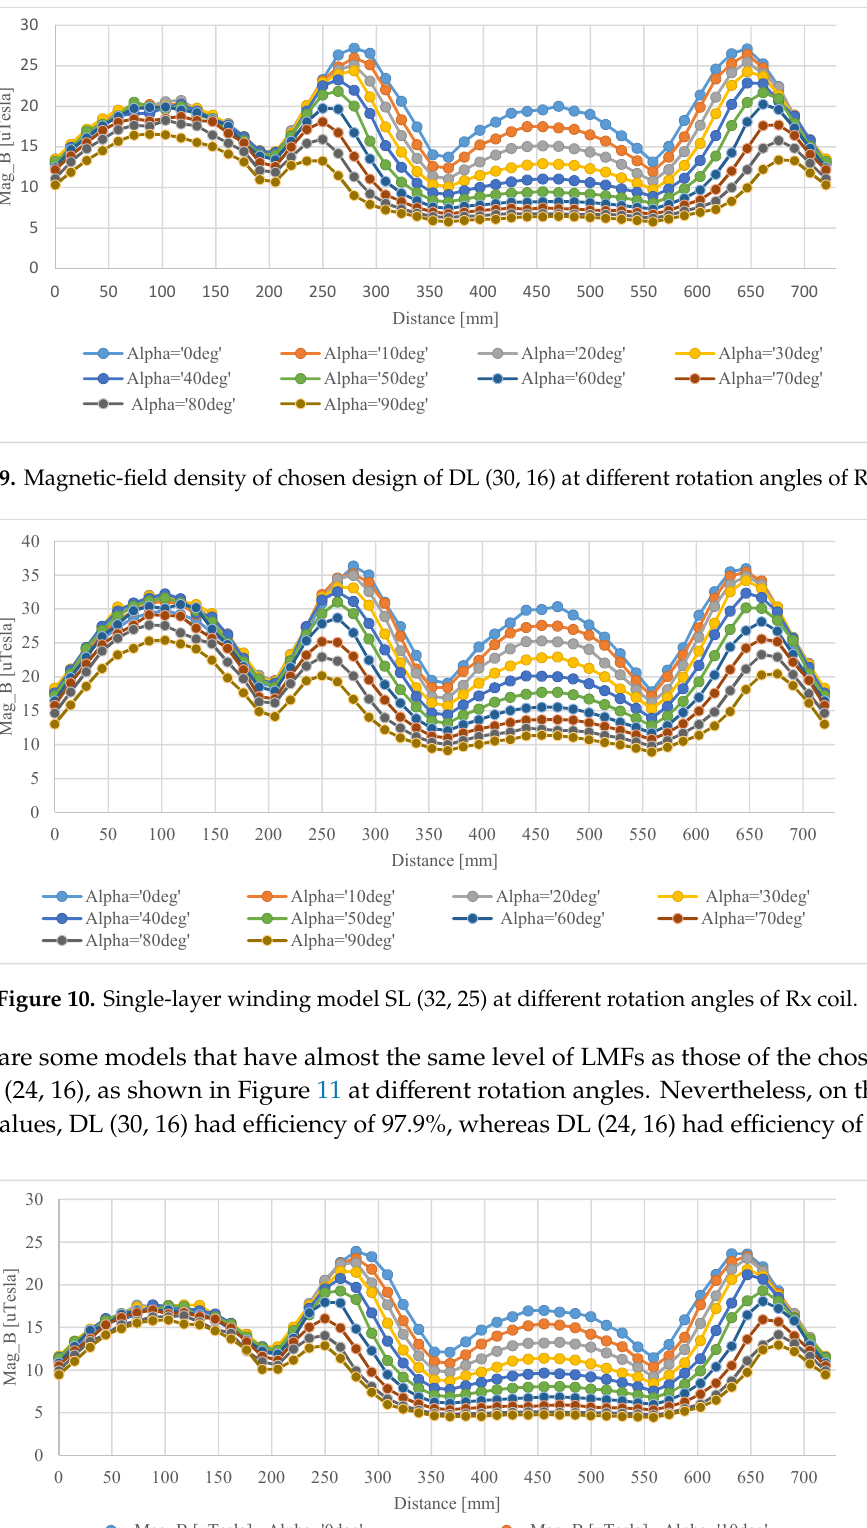
Figure 8. Magnetic-field density ( B ): comparison of different WPT systems.